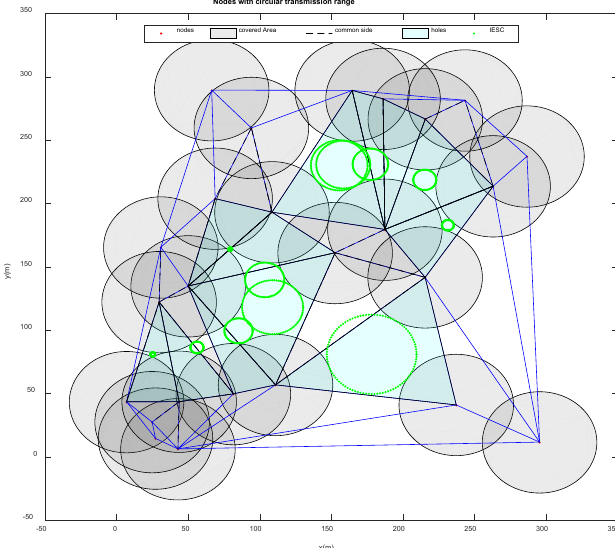
Figure 2. Coverage holes area by advanced DT Algorithm 1. Coverage hole detection process